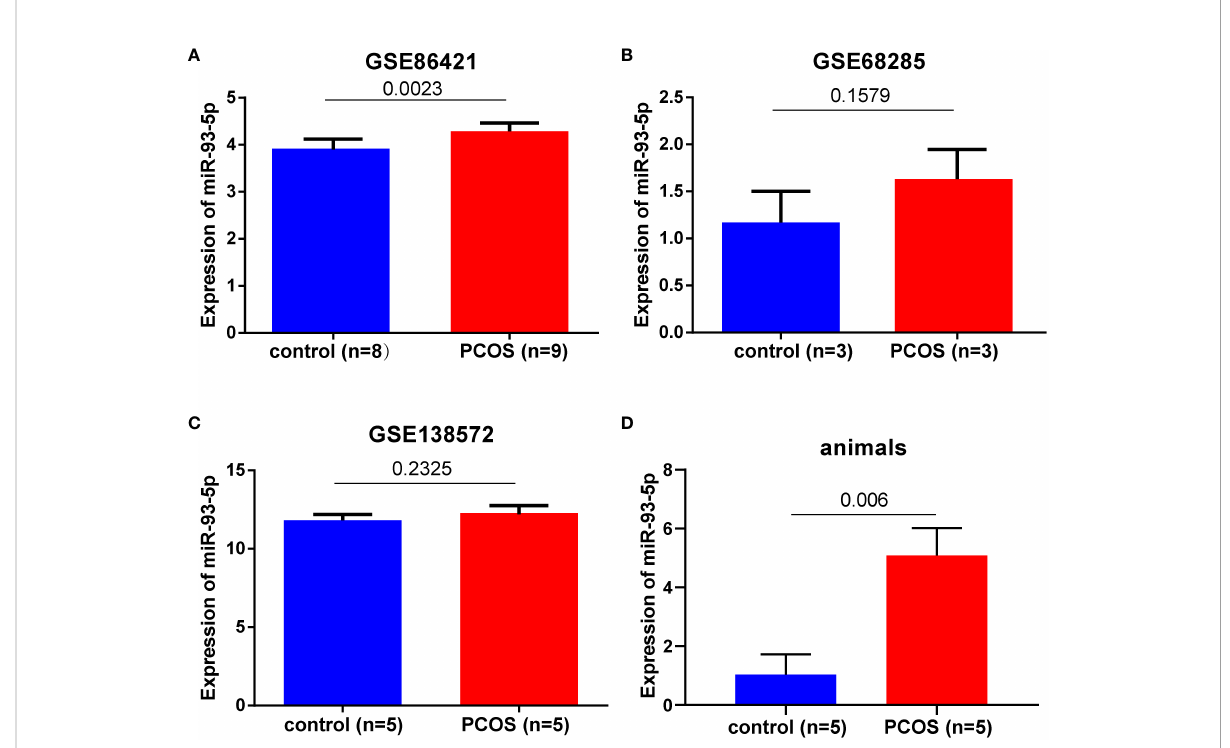
FIGURE 1 The expression level of miR-93-5p in GCs of PCOS and heath controls. miR-93-5p expression in (A) GSE86421, (B) GSE68285, (C) GSE138572, (D) ovarian tissues of PCOS mice (n=5) and controls